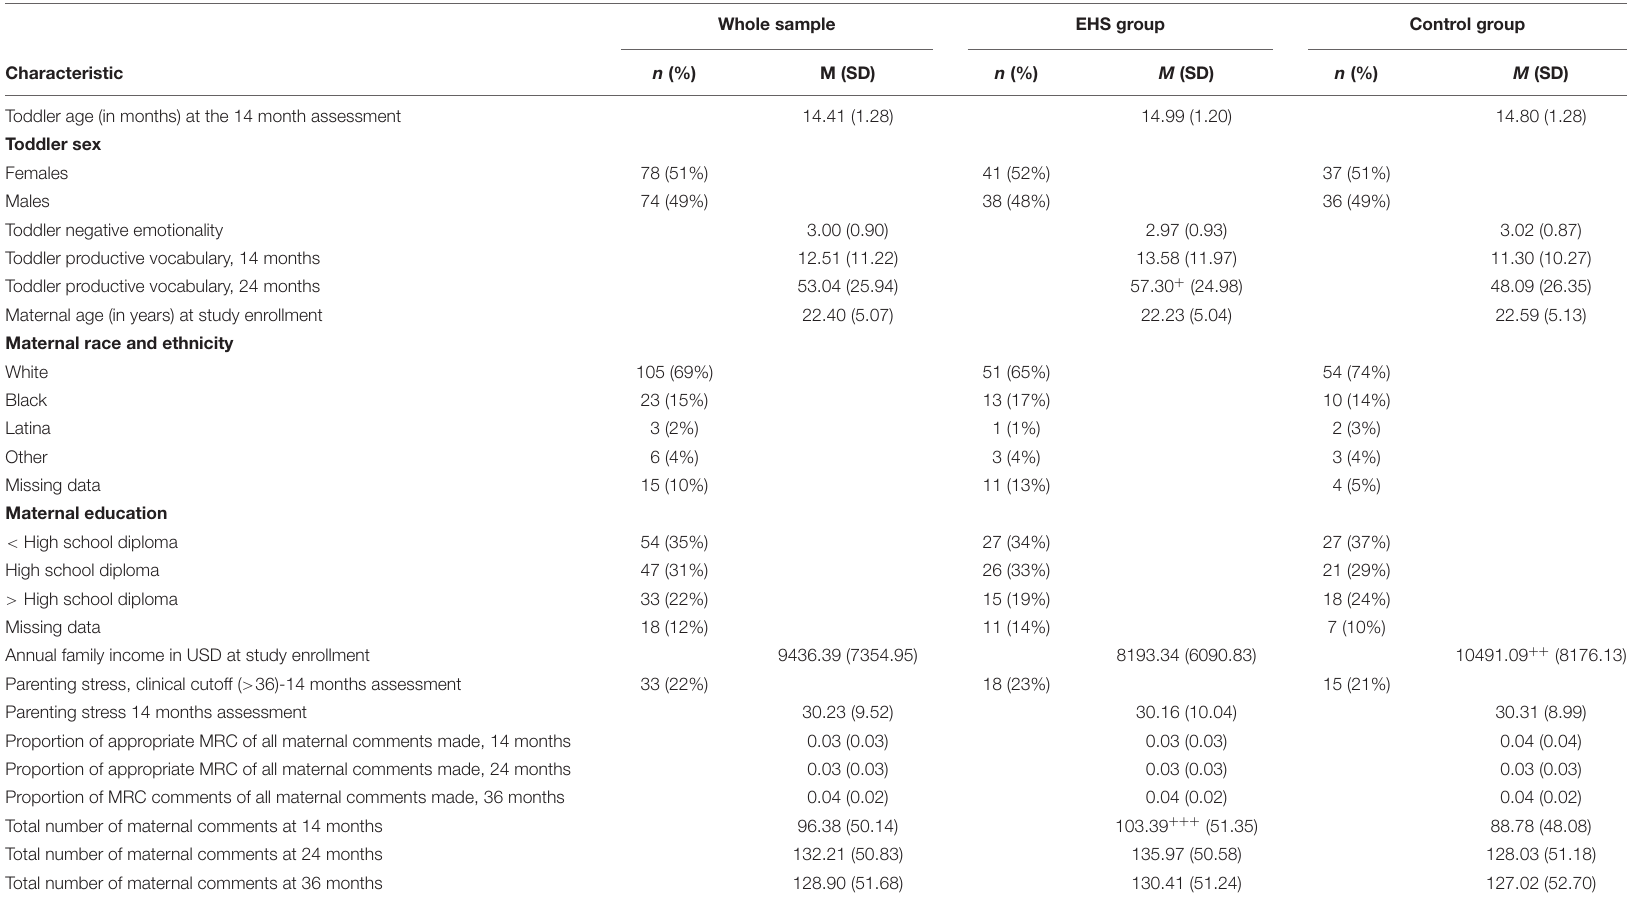
TABLE 1 | Frequencies, means, and standard deviations for study variables.